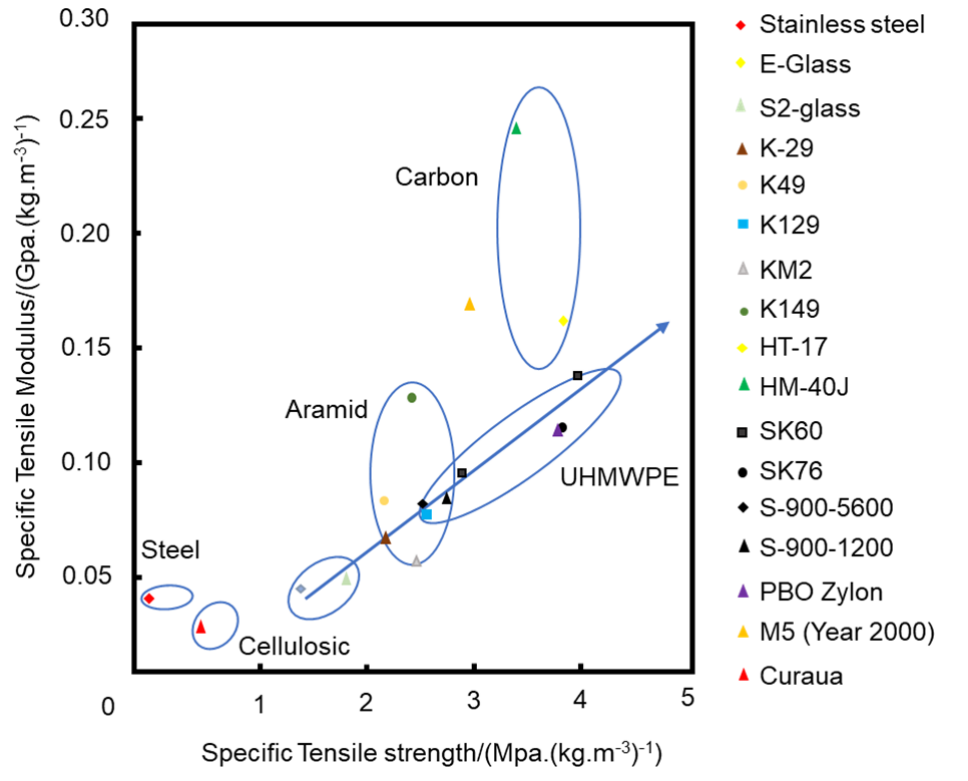
Figure 2. Specific tensile strength and modulus of high performance fibers [10].